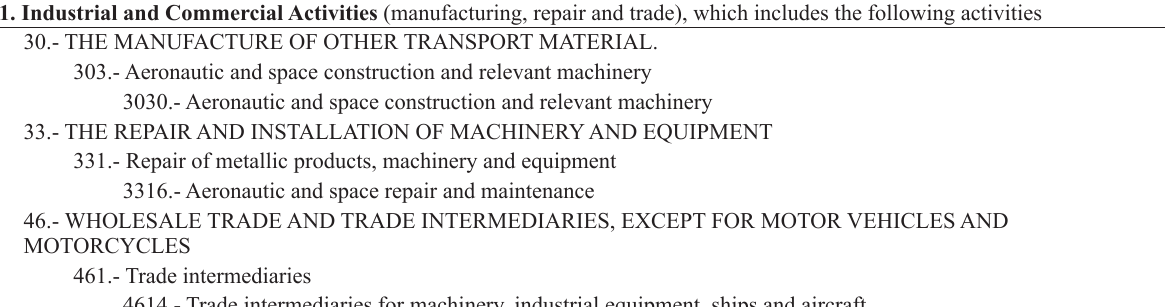
Creation of the Spanish Industrial Aerospace Sector